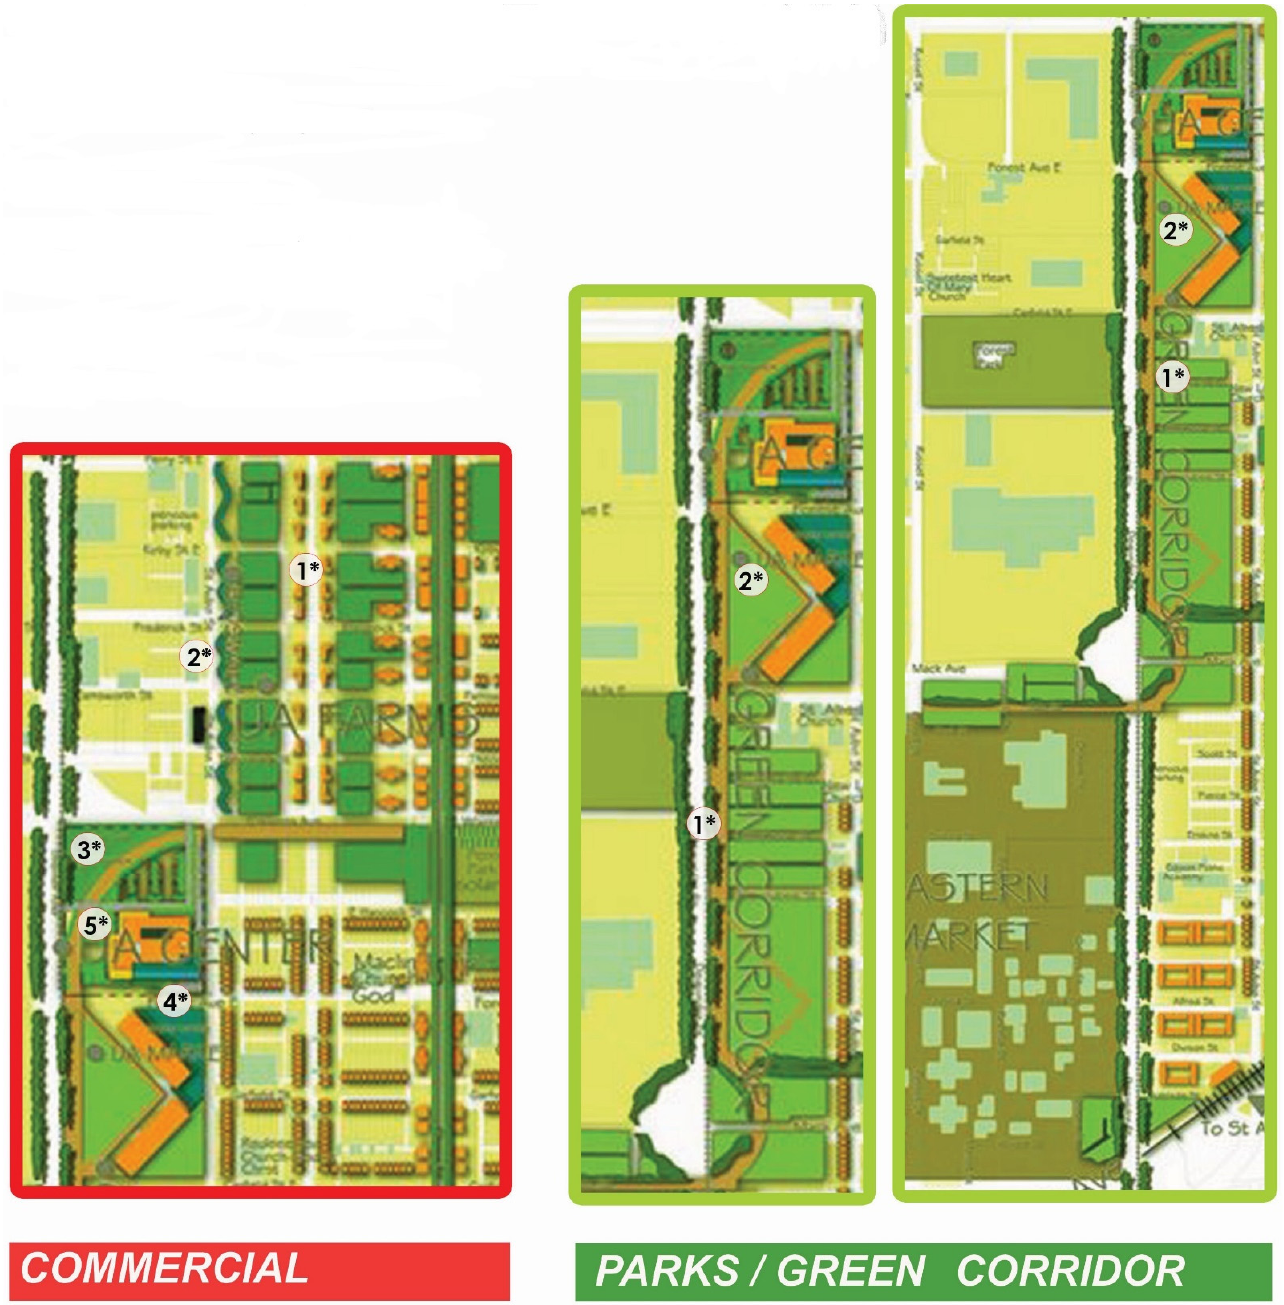
Figure 14. An example of a plan map for urban farm types.